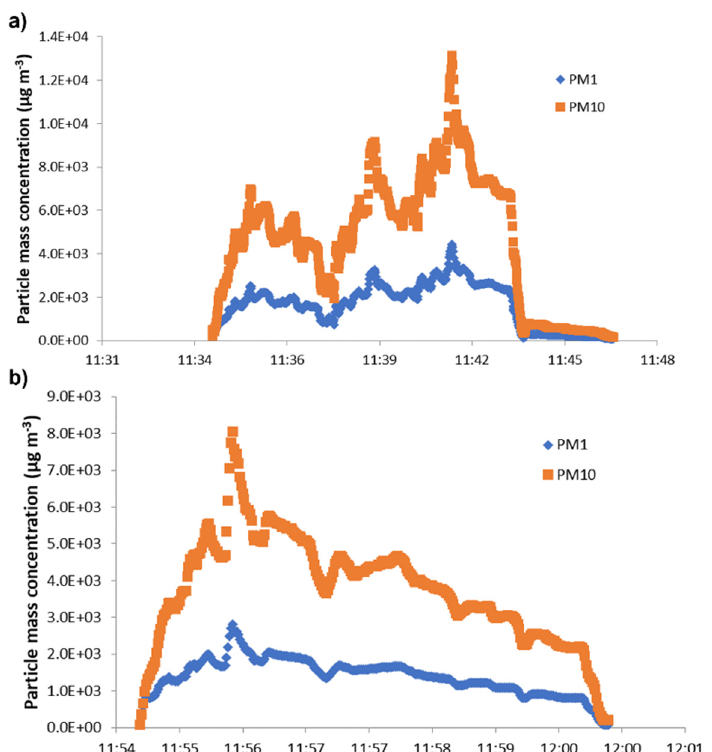
Figure 4. PM1 and PM10 particle mass concentration measured within the spray chamber for ( a ) run 1 (three spray transits) and ( b ) run 2 (one spray transit). Both tests were performed at 1 bar nozzle pressure. The temporal distance between spray coatings (run 1) was about 2/3 min.